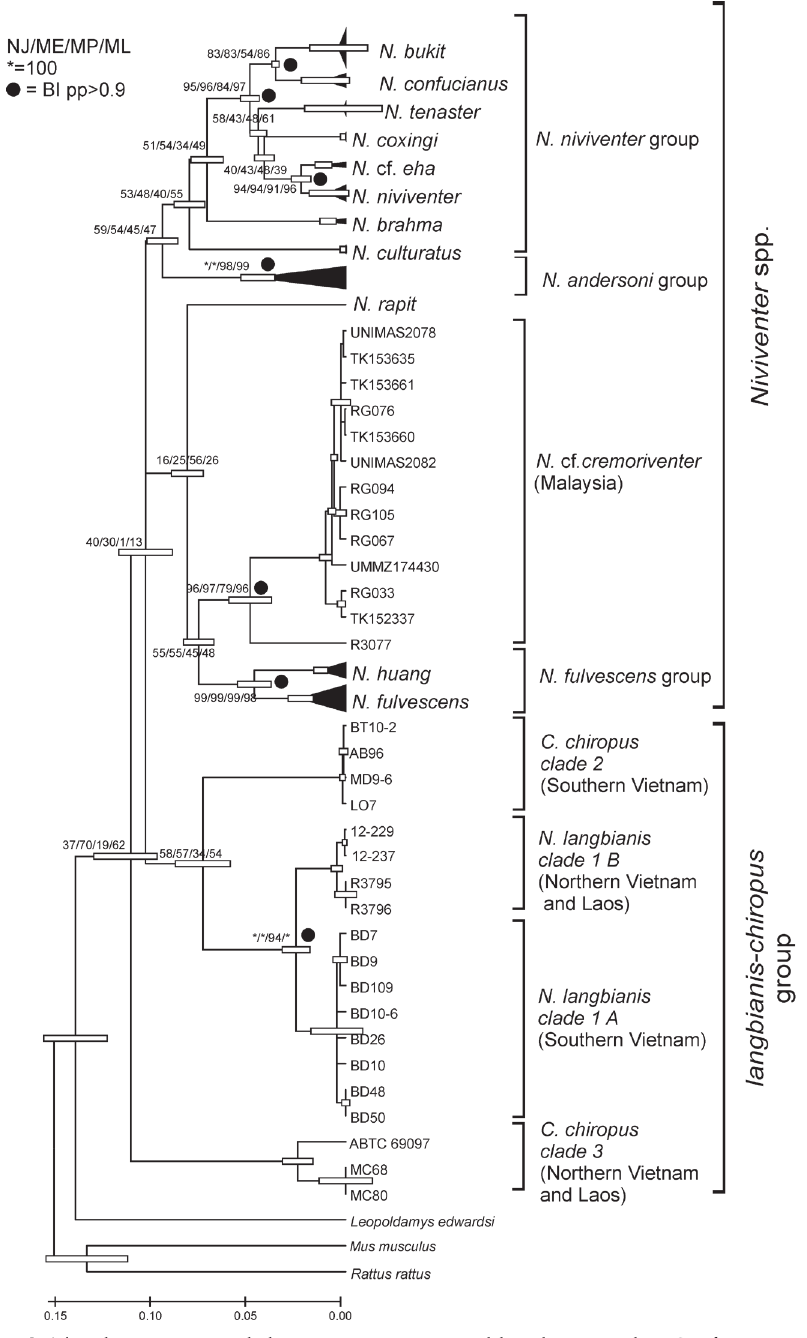
Figure 1. The ultrametric ML phylogenetic tree constructed based on complete Cyt b gene sequences (TN93+G+I; 1-2-3 pos. inc.) of the Niviventer - Chiromyscus complex. The scale bars at the bottom represent the level of divergence ( d , T3P). The bars at the nodes represent the level of confidence of branch